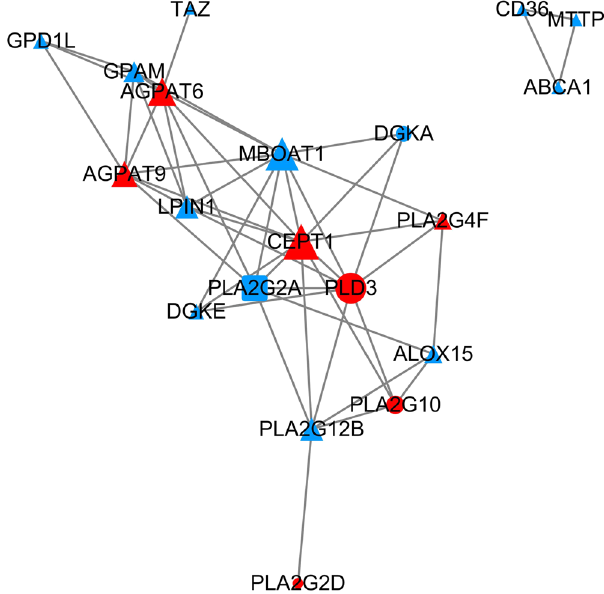
Figure 6. Protein-protein interaction networks of lipid metabolism related pathway enriched genes. The node size was decided on the basis of the interaction degree value of each gene. Triangle node: FPKM < 10 in either the cecum or colon; Circular node: 10 ≤ FPKM < 500 in the tissue with the highest expression; Square node: FPKM ≥ 500 in at least one intestinal tissue. Red: Higher expressed in colon; Blue: Higher expressed in cecum; Green: Multiple transcript expression patterns are not